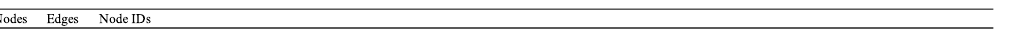
TABLE 2 | Clusters of networks analyzed by